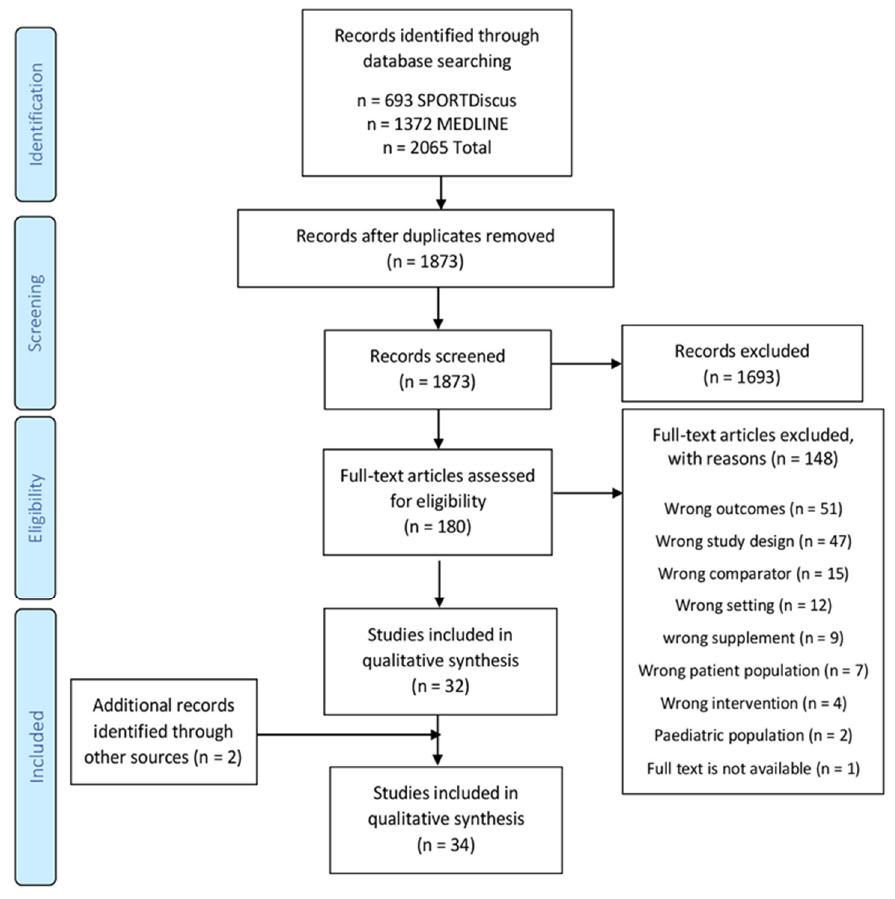
Figure 1. PRISMA flow diagram of the literature search strategy.